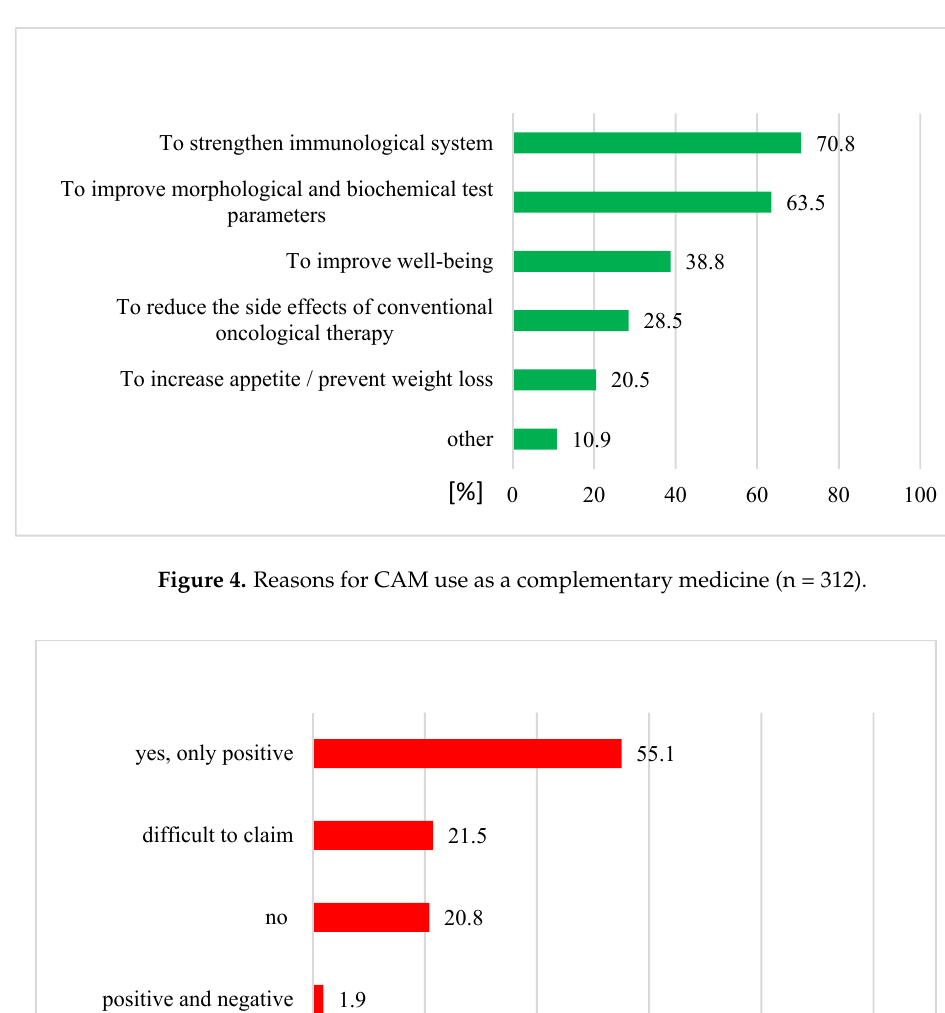
Table 2. The answers of patients who declared that they had used CAM as an alternative medicine (n = 30).